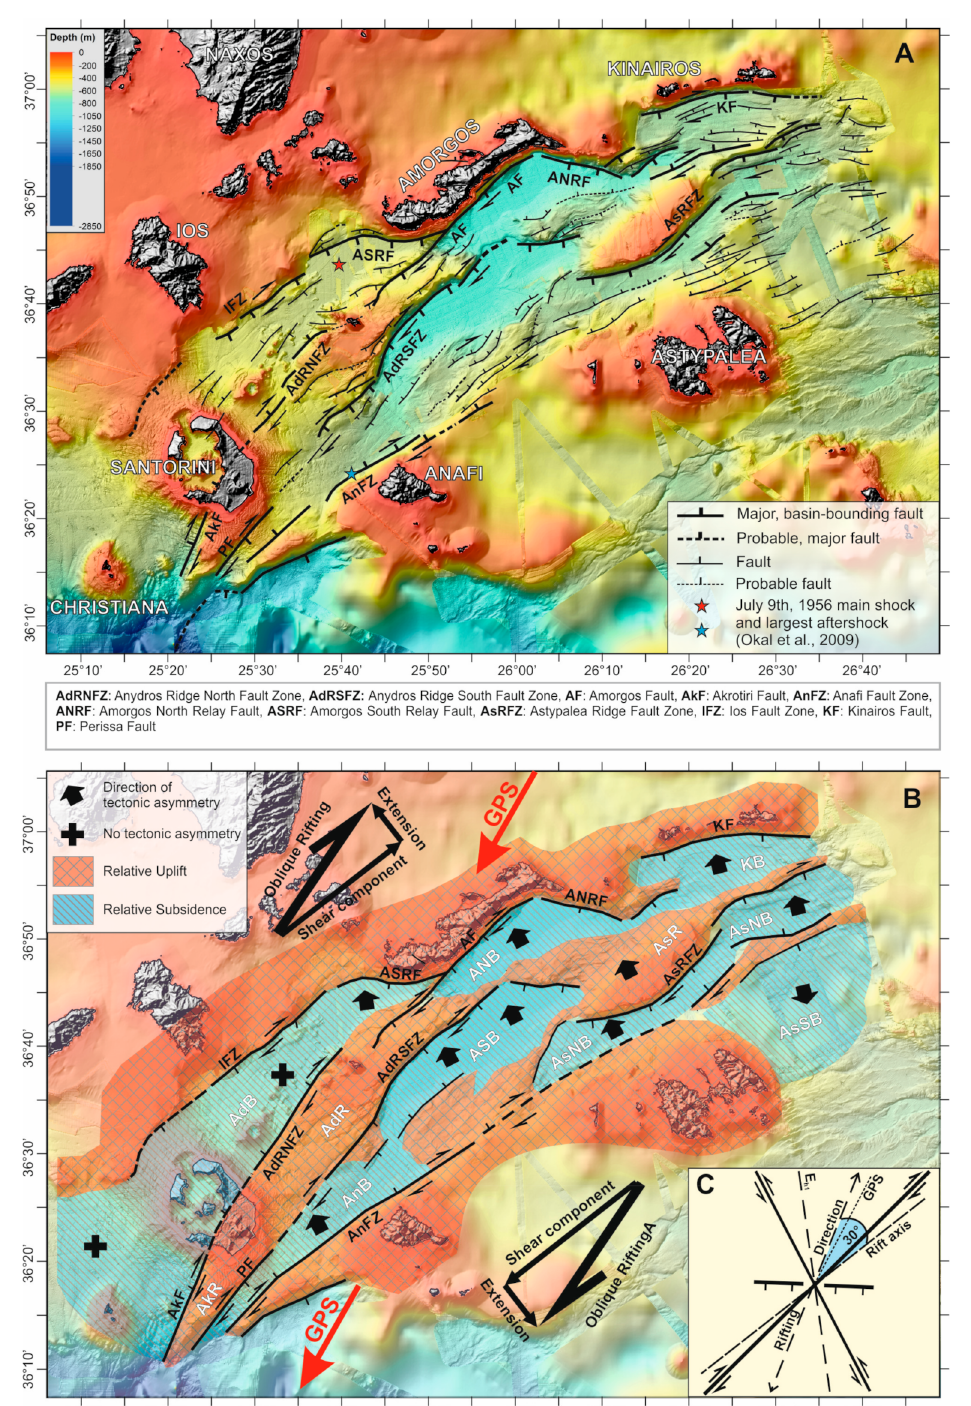
Figure 9. ( A ): Detailed map of the active fault network in Santorini-Amorgos Shear Zone. Teeth on the faults indicate the downthrown side. Half arrows show the sense of lateral motion. ( B ): Tectonic and kinematic map of Santorini-Amorgos Shear Zone. Dextral oblique rifting results from dextral strike-slip motion in NE-SW direction and extension in NW-SE direction. Red arrows show the direction of motion in respect to stable Eurasia, modified after Kreemer and Chamot-Rooke [36]. ( C ): Drawing explaining the kinematic of dextral oblique extension with the rift axis running at 30° in respect to the rifting direction (modified after Withjack and Jamison,